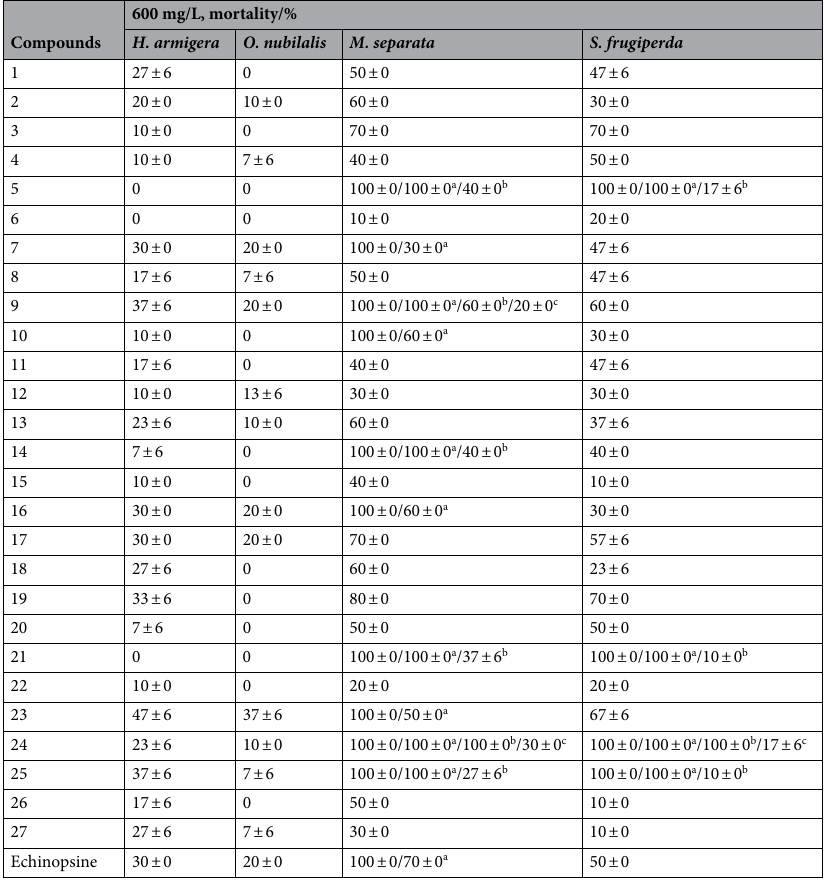
Table 3. Insecticidal activity of compounds 1 – 27 and echinopsineagainst Cotton Bollworm ( Helicoverpa armigera ), Corn Borer ( Ostrinia nubilalis ), Oriental Armyworm ( Mythimna separata ), Fall Armyworm ( Spodoptera Frugiperda (J. E. Smith)). a Mortality at 200 mg/L, b Mortality at100 mg/L, c Mortality at 50